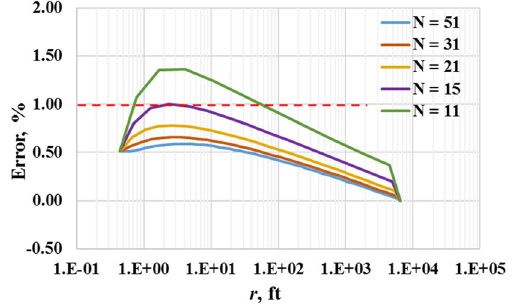
Fig. 4 Error vs. distance from wellbore for different total number of